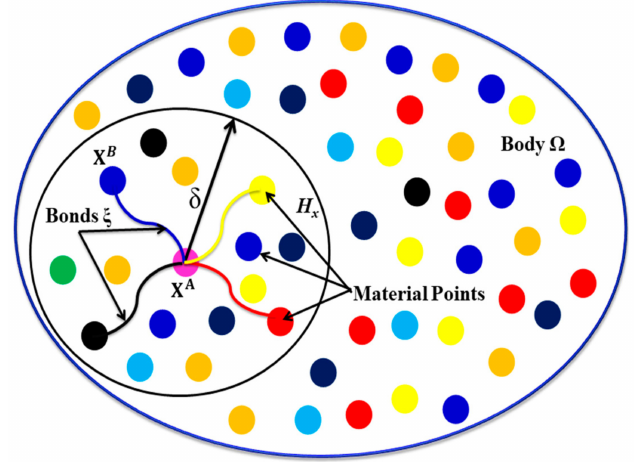
Figure 1. Peridynamic representation of problem domain; here, point X A is influenced by all points within its horizon. H is the horizon of X A , and δ is the radius of the horizon. X A